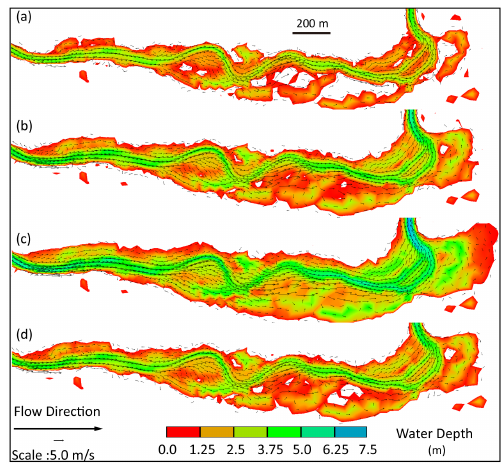
Figure 10. Inundation maps of the 50 year flood event under dif- ferent flood stages; (a) and (b) are located on the flood rising stage, (c) corresponds to peak discharge, and (d) is located on the flood recession